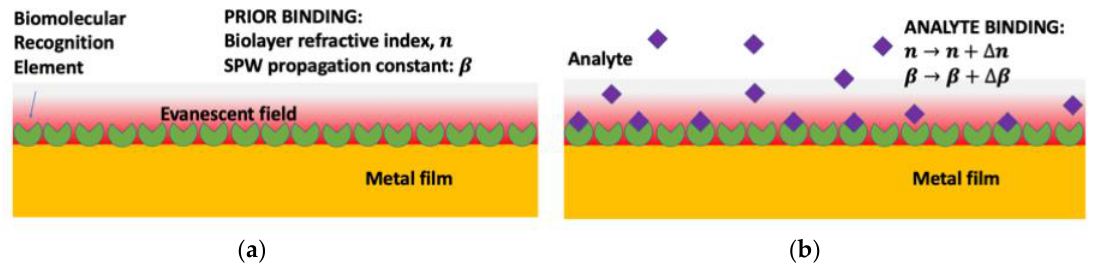
Figure 1. Principle of surface plasmon resonance (SPR) sensor: ( a ) prior to binding and ( b ) analyte binding where the number of analytes captured results in a change in the index of refraction (RI) near the surface of the metal layer.